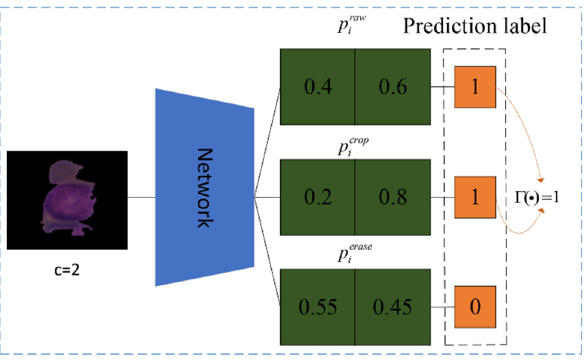
Figure 5. The example of the voting algorithm. The number of categories is 2 c = .